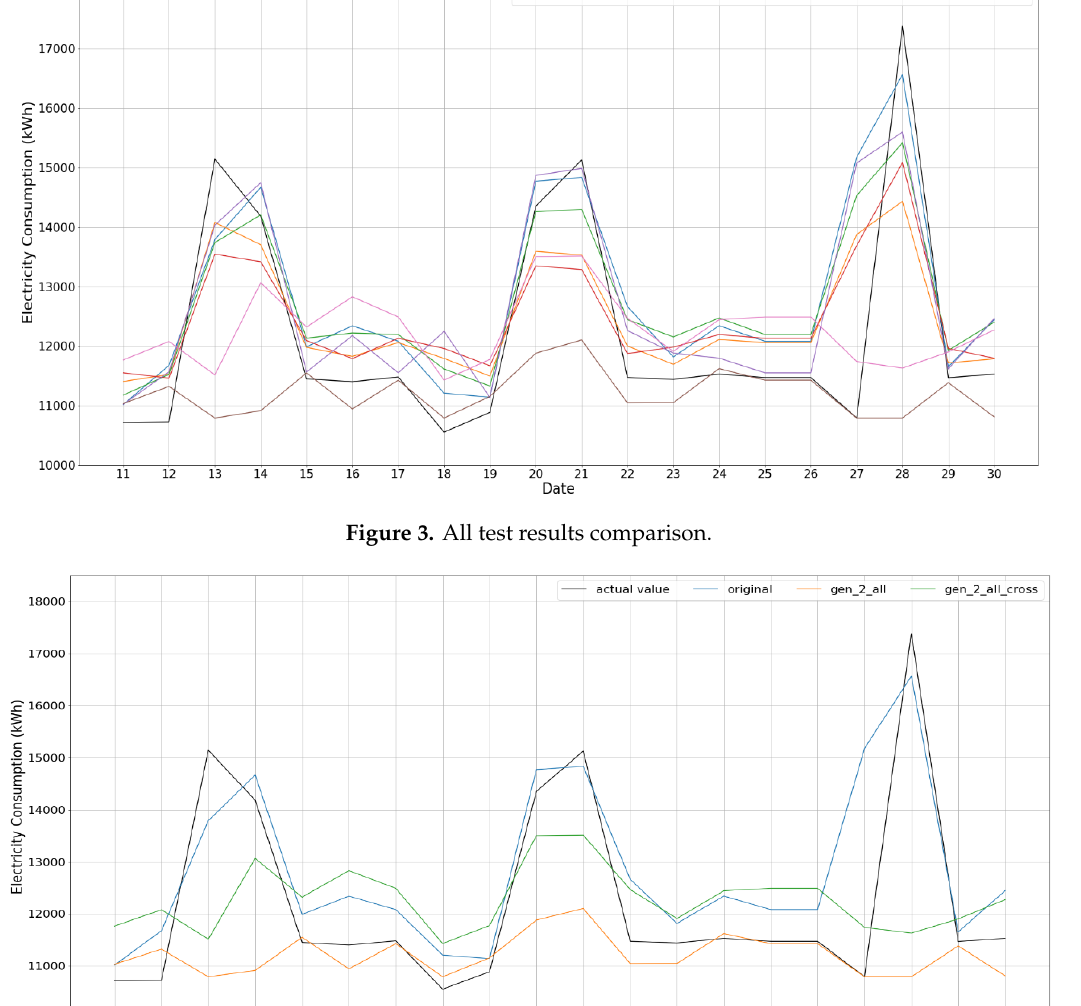
Figure 3. All test results comparison.